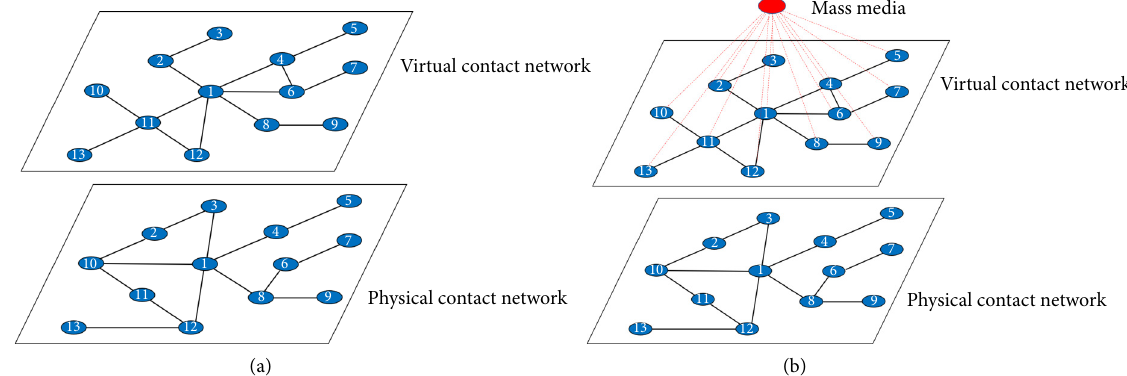
Fig. 1 (a) Two network model (from Ref. [10]). (b) Two network model with mass media (from Ref.